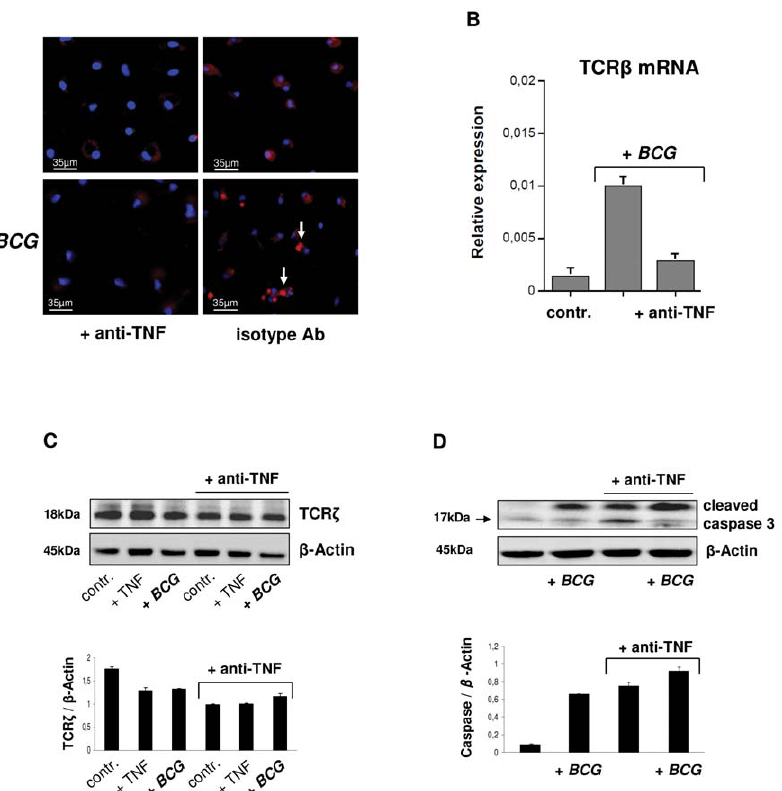
Figure 7. TNF blockade inhibits expression of the macrophage-TCR ab . ( A ) Suppression of the TCR ab in uninfected and BCG infected IFN c macrophages in response to 2h treatment with the anti-TNF antibody infliximab (50 m g/ml). An irrelevant monospecific antibody (anti-CD20) was used as control. Macrophages were immunostained using an anti-TCR ab antibody (Alexa 555-labeled, red). Representative fluorescent microscopy images are shown. Infection with BCG mycobacteria changes the staining pattern from diffuse surface staining to a bright central spot (arrows). Nuclei, DAPI (blue). ( B ) Anti-TNF treatment (infliximab) downregulates mRNA expression of the TCR b constant chain in IFN c macrophages as assessed by qPCR. Control, uninfected macrophages. ( C ) Downregulation of the f -subunit of the TCR signaling complex and increased levels of cleaved caspase 3 ( D ) in uninfected (controls, + TNF) and BCG infected IFN c macrophages following TNF blockade (infliximab). Controls, untreated macrophages; + TNF, macrophages stimulated with TNF (10 ng/ml). Bar graphs (mean 6 SEM) represent quantitative analyses of qPCR or densitometry of the immunoblots from two independent experiments. Representative immunoblots are shown. Whole cell lysates from IFN c macrophages were immunoblotted using antibodies to TCR f , cleaved caspase 3 and b -actin, respectively. Quantitative densitometrical analyses of the immunoblots was normalized to b -actin.